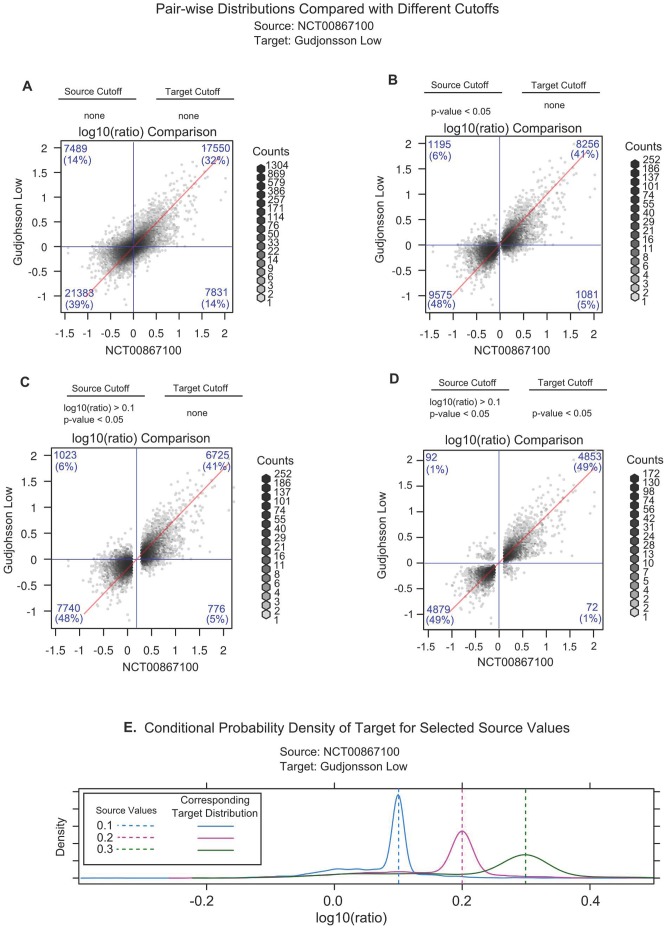
Effect of Implementing Fold-Change and p-value Cut-offs on a Comparison Between Two Experiments.Panels A-D show a hexbin plot comparison of the average log10(ratio) values between the Gudjonsson Low and the NCT00867100 data sets with (A) no cut-offs, (B) a p-value≤0.05 cut-off in the source set only, (C) p-value≤0.05 and log10(ratio)≥0.1 cut-offs only in the source set, and (D) p-value≤0.05 and log10(ratio)≥0.1 cut-offs in the source set and a p-value≤0.05 cut-off in the target set. The numbers in the panel corners indicate the number of data points in those quadrants. Panel E shows average log10(ratio) distributions in the Gudjonsson Low data set (target set) for sequences with log10(ratio) values of 0.100±0.005 (blue), 0.200±0.005 (pink), and 0.300±0.005 (green) in the source set (NCT00867100).